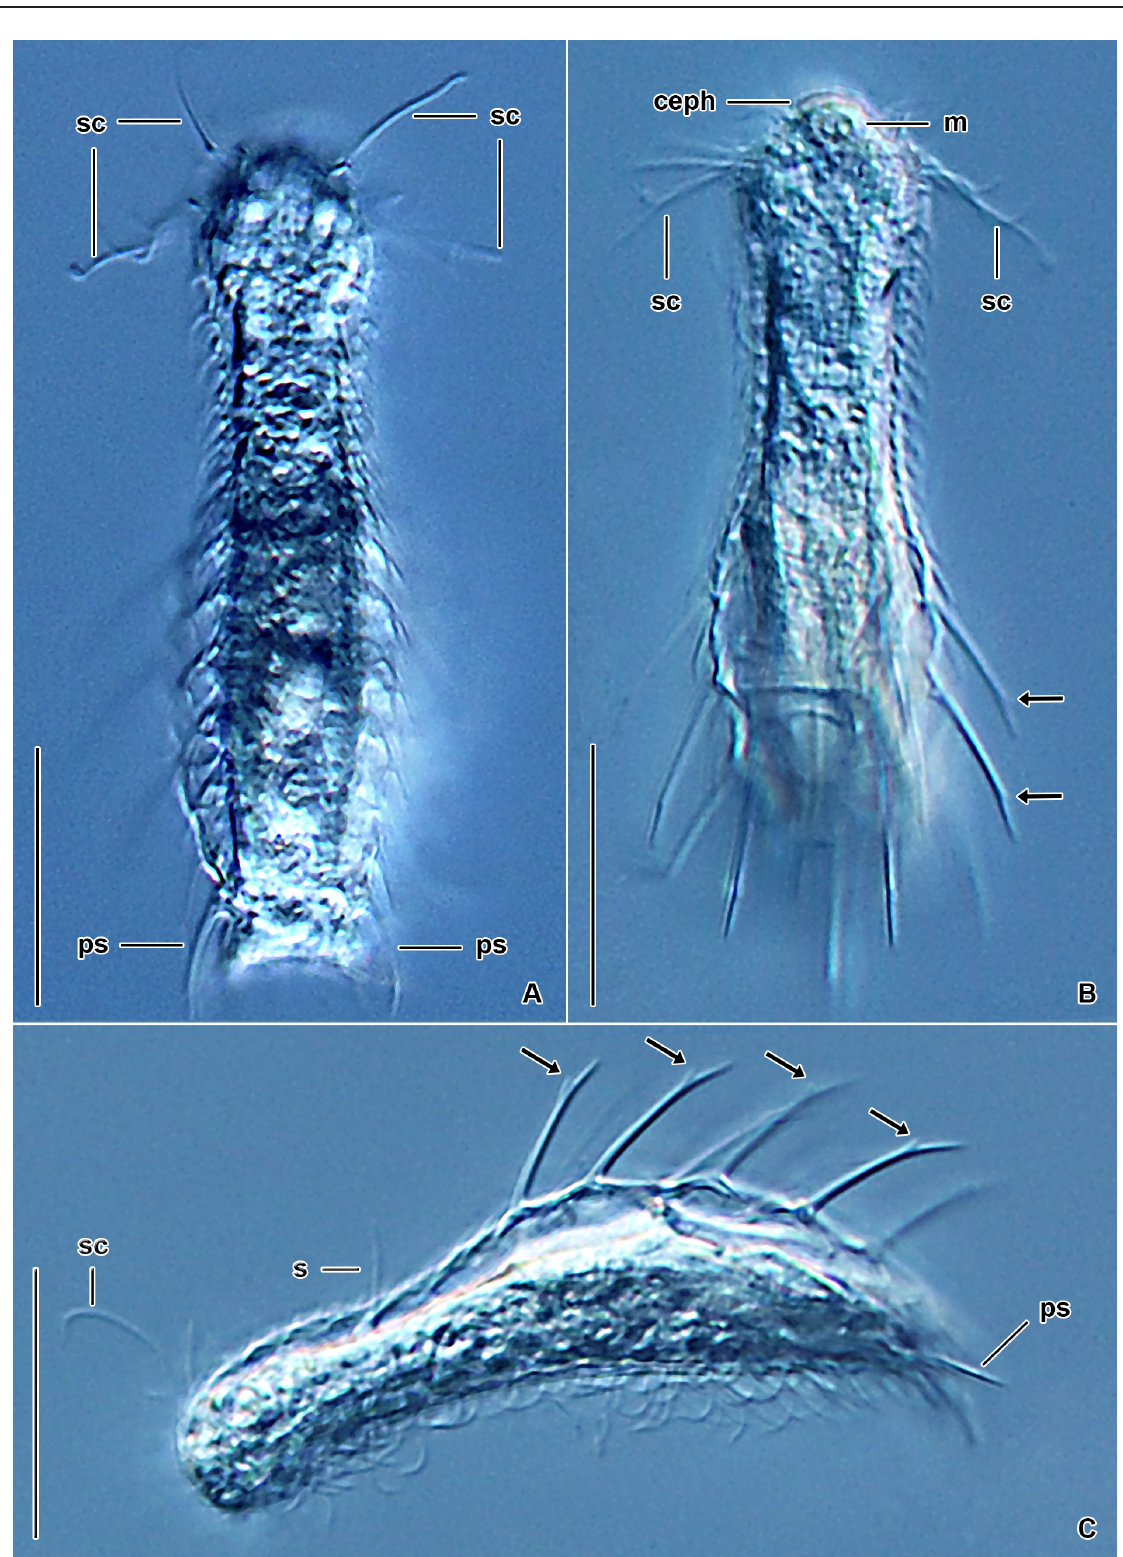
Fig. 12. Chaetonotus ( Hystricochaetonotus ) mirabilis sp. nov., holotype (CU-FNS-11-09-19/HO), differential interference contrast. A‒B . Optical sections showing the general body organization. C . Lateral overview. Arrows in (B) and (C) mark the lateral denticle of spines. Scale bars = 30